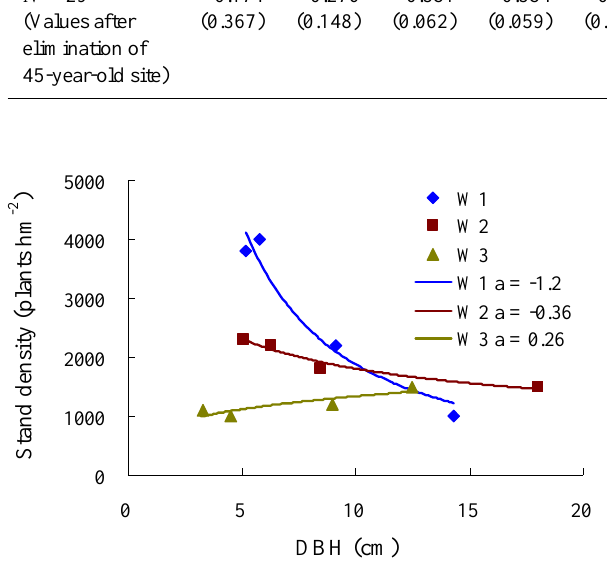
Fig. 3. Logarithmic regression between plant size and density.